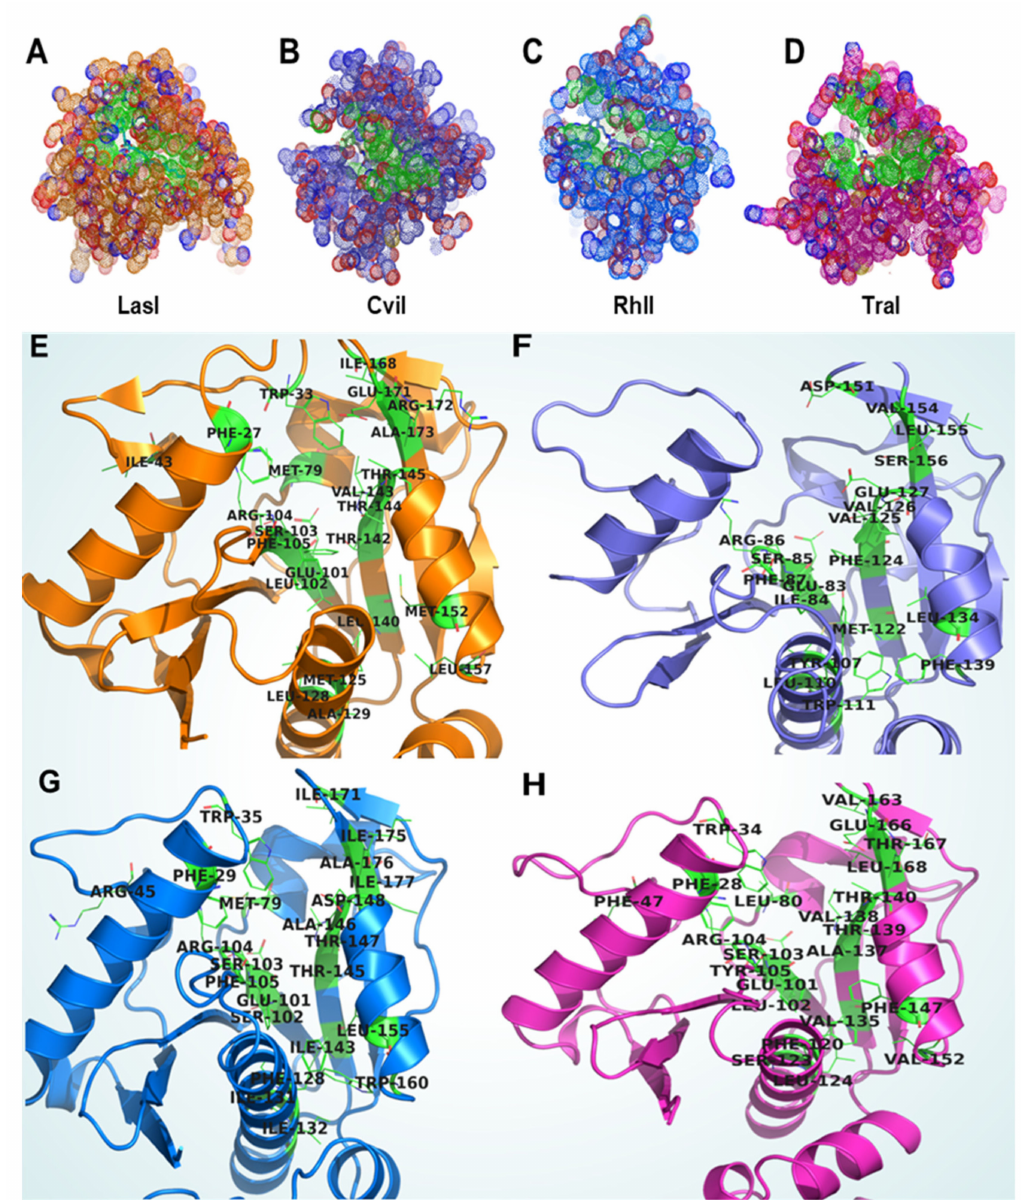
Figure 4. Detailed map of AHL synthases active sites. The dot representation of the protein highlights the active site (green) of AHL synthase proteins (LasI, CviI, RhlI, and TraI) ( A – D ). Detailed map of the residues of binding pocket in LasI ( E ), CviI ( F ), RhlI ( G ), and TraI ( H